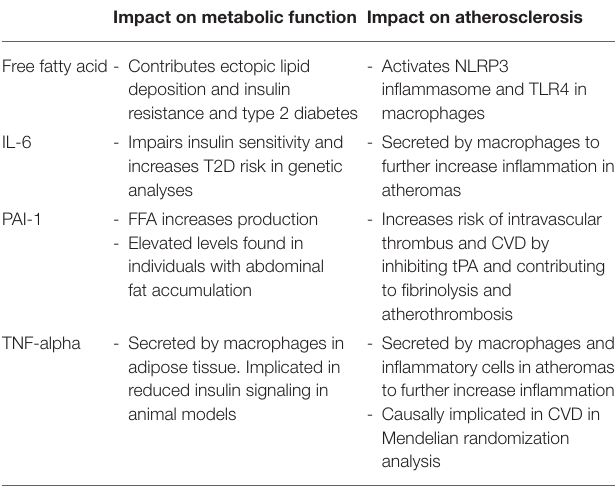
TABLE 1 | Critical regulators of inflammation in obesity and CVD (50,